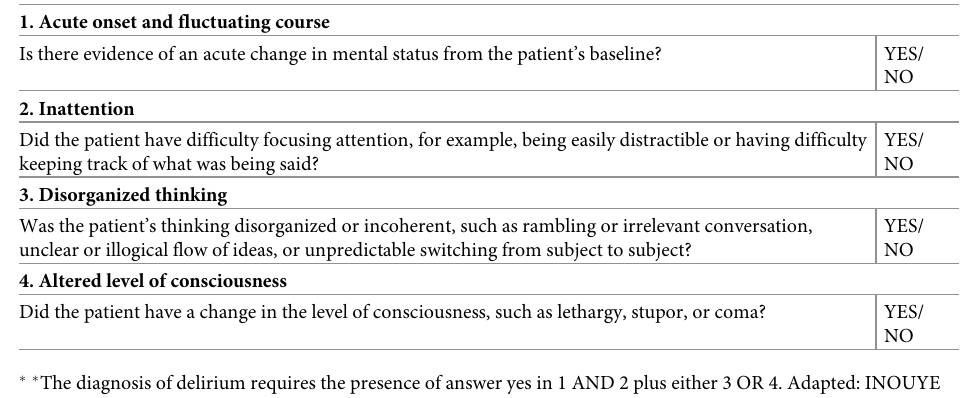
Table 1. Confusion Assessment Method